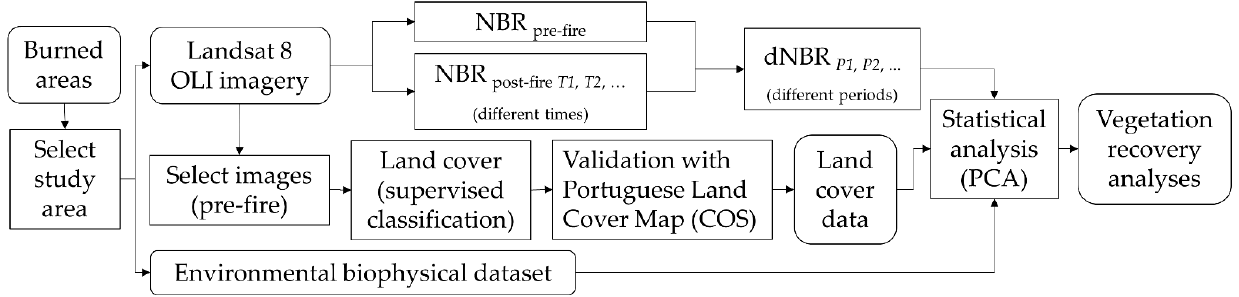
Figure 3. Workflow of vegetation recovery analyses in burned areas.